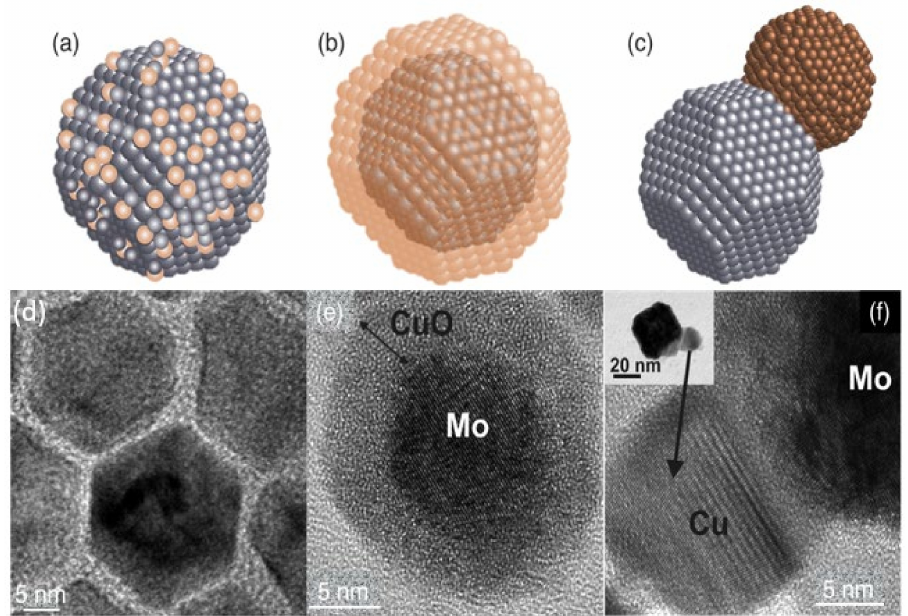
Figure 1. Basic structural forms of nanoparticles containing more than one element: ( a ) a uniform Pt-Ni alloy; ( b ) a Mo@CuO core–shell nanoparticle; ( c ) a Mo-Cu Janus particle. ( d ) Reproduced with permission from [22]; ( e , f ) reproduced with permission from